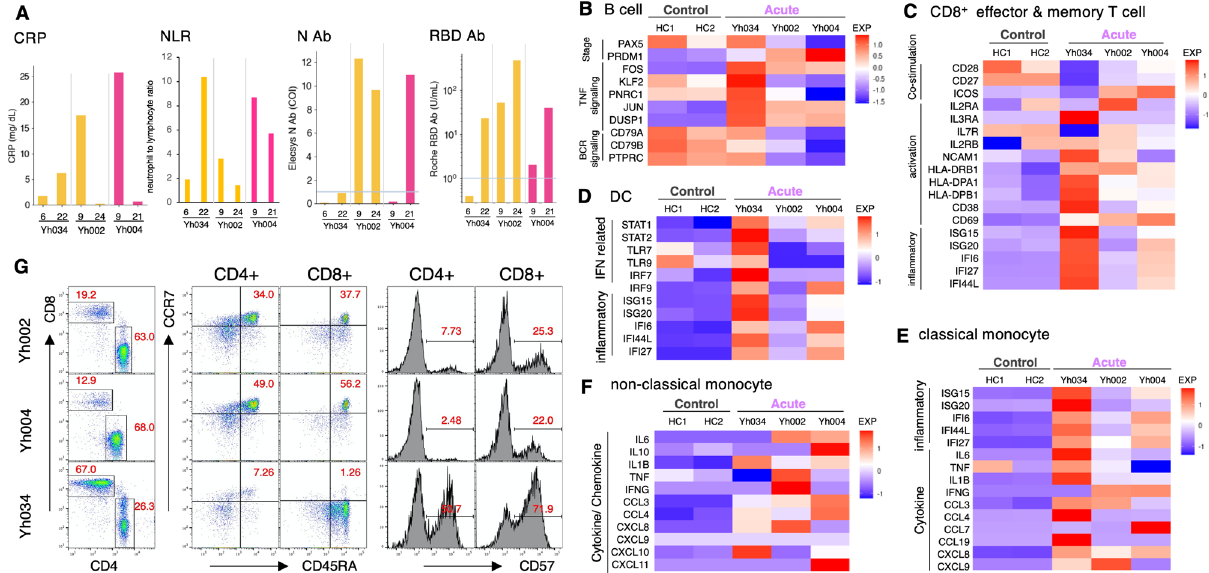
Figure 4. Immune profiles of severe/critical patients in acute phase. (A) Clinical information of Yh034, Yh002, and Yh004. CRP, NLR, and SARS-CoV-2 antibody level of the anti-RBD and anti-N regions are shown. (B) Expression level of development, TNF signaling, and BCR signaling activation markers in B cells. (C) Expression level of co-stimulation, activation, and inflammatory markers in effector and memory CD8 + T cells. (D) Expression level of IFN-γ-related and inflammatory markers in DC. (E) Expression level of inflammatory and cytokine-related genes in classical monocytes. (F) Expression level of cytokine/chemokine-related genes in non-classical monocytes. Color key for heatmap is shown in the margin. (G) FACS